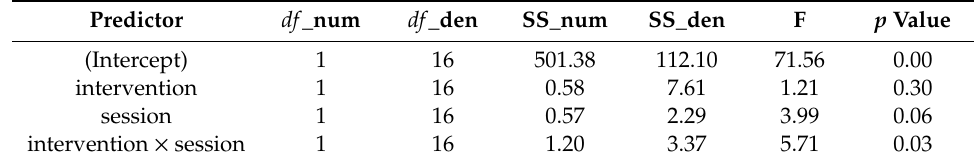
Table 3. ANOVA – N30 Amplitude. Table 3. ANOVA–N30 Amplitude.